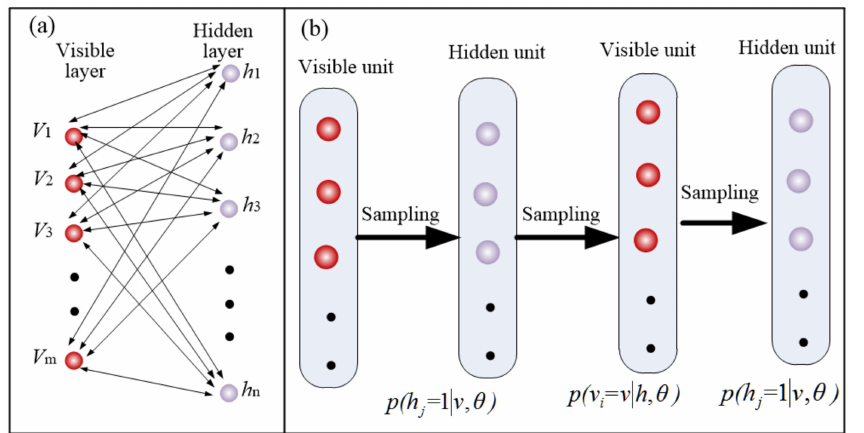
Figure 4. Diagram of Gaussian-restricted Boltzmann machine ( a ), and pre-training process ( b